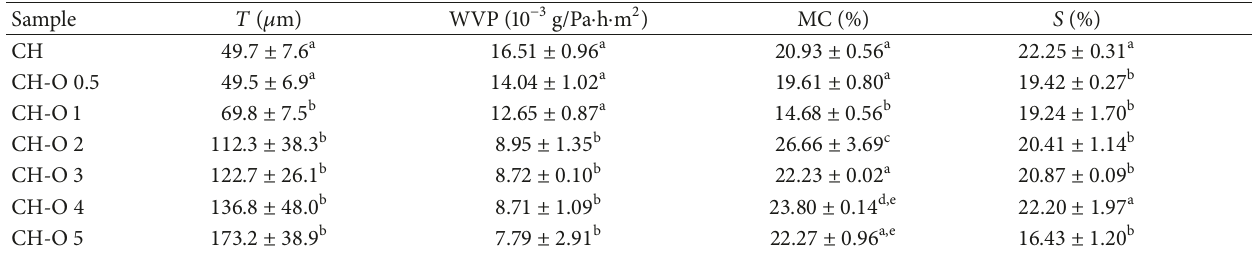
Table 4: Physical properties of chitosan films with the oregano essential oil.